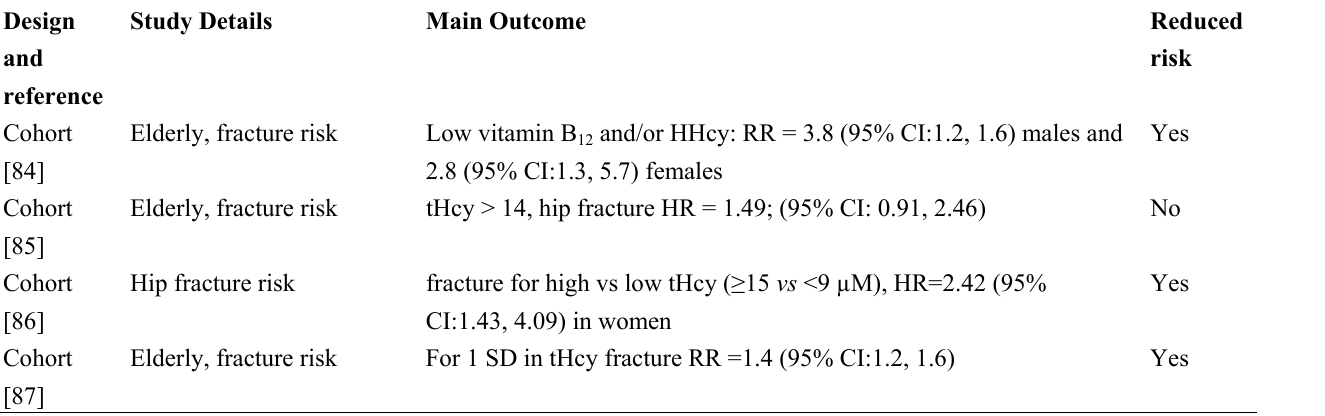
and risk of osteoporosis or 12